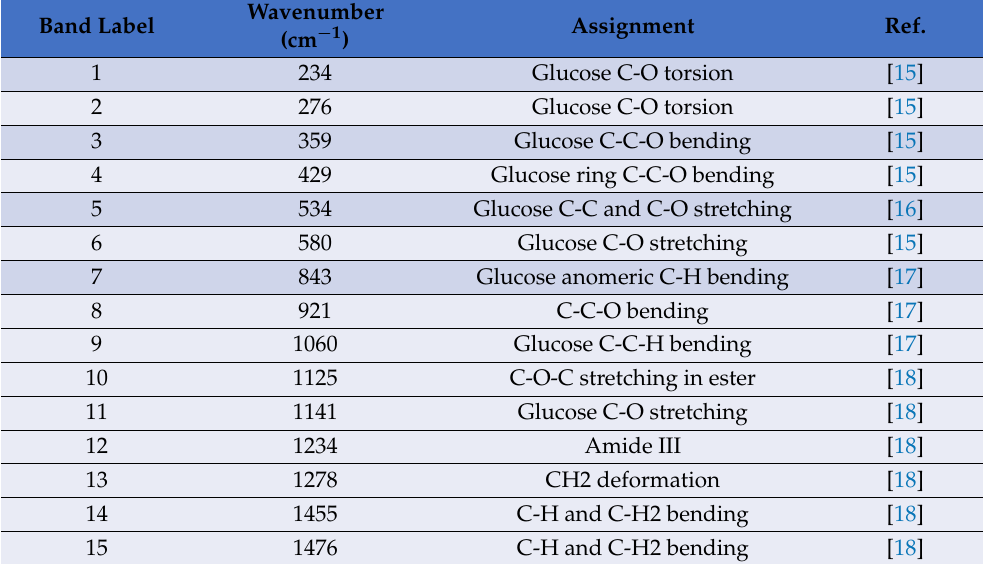
Table 1. Wavenumbers and vibrational assignments of the main Raman bands found in the spectrum of the NanoCliP-FD gel scaffold (band labels correspond to those shown in Figure 4a. Band Label